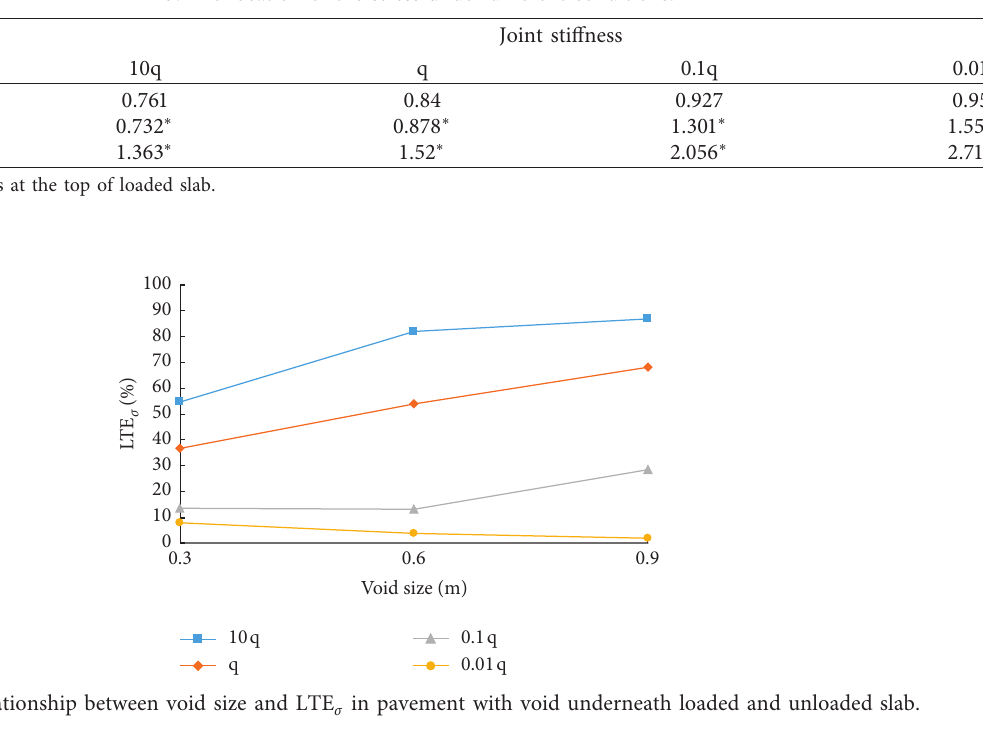
Figure 15: Effect of void size on stress of the loaded slab with void underneath loaded and unloaded slab. Table 3: The location of the stress under different conditions.